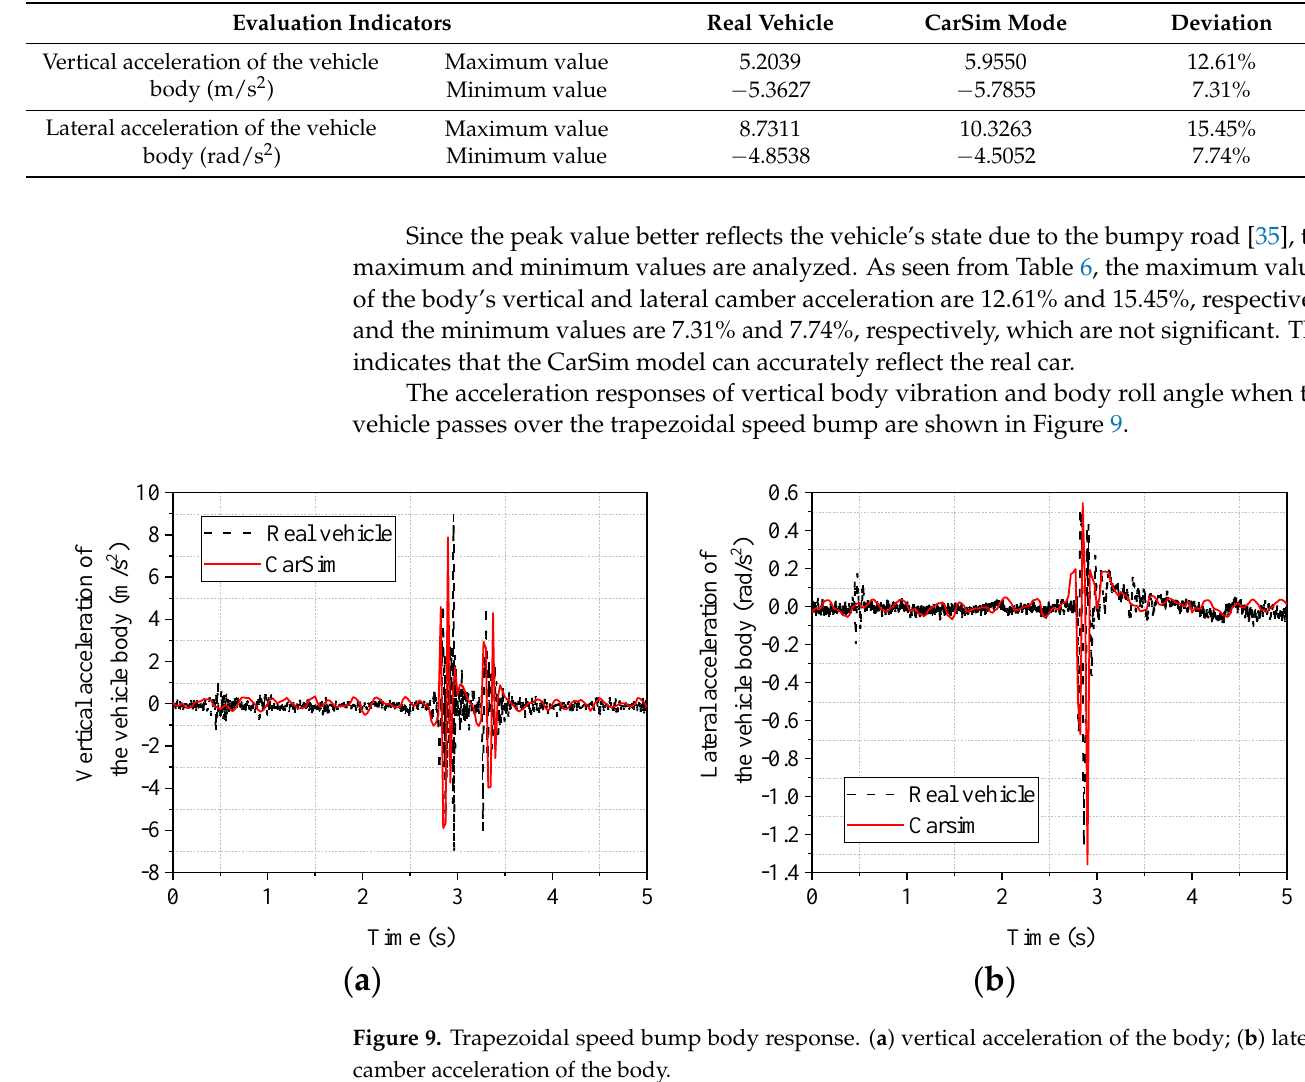
Table 6. Time domain response of vehicle body passing over a triangular speed bump.